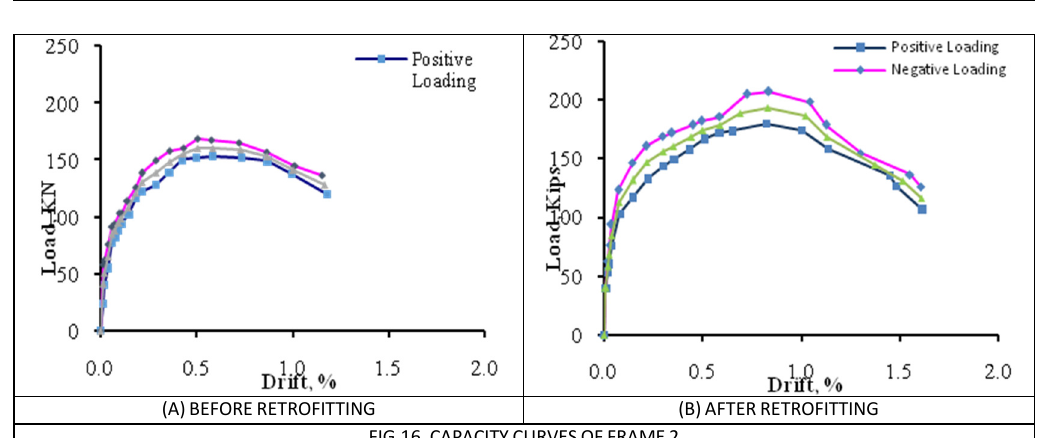
FIG.15. CAPACITY CURVE OF FRAME-1